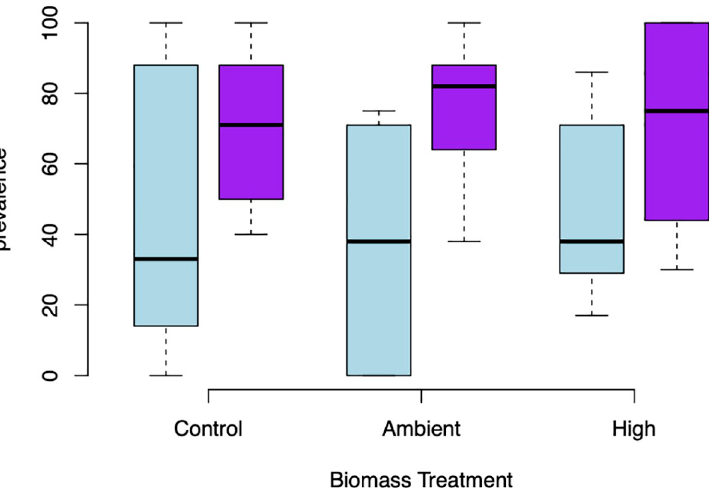
Fig 1. Infection status by snail taxon. Prevalence, the percentage of infected individuals per replicate, of all trematode infections by Biomass treatment (Control, with no Potamopyrgus , Ambient levels of Potamopyrgus in Polecat Creek, and High biomass) for Galba (light blue) and Pyrgulopsis (purple). Boxplots show the median, the interquartile range (shown by the upper and lower edges of the box), and the 1.5 interquartile ranges